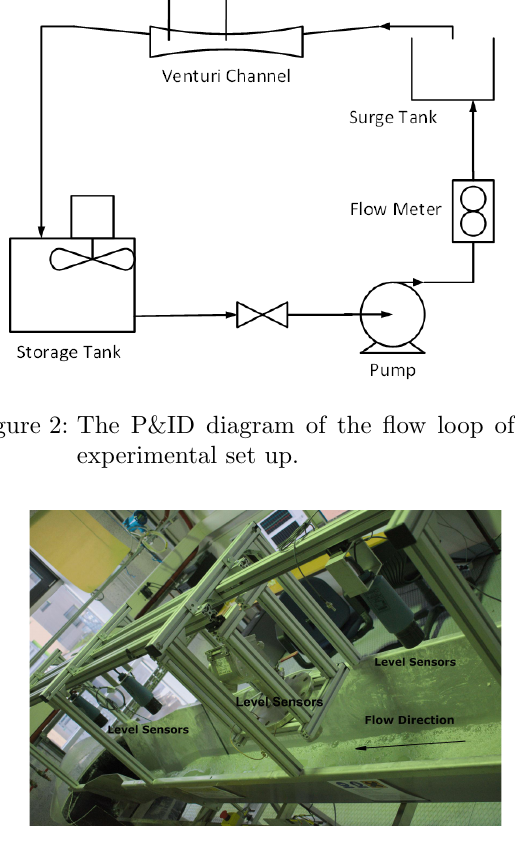
Figure 3: The Venturi channel at operation with differ- ent level